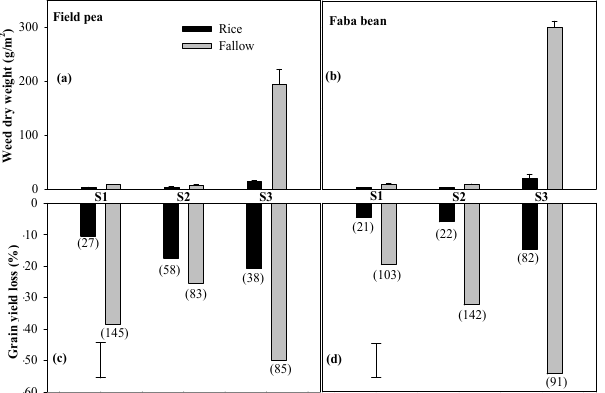
Figure 7. Weed dry weight ( a ), ( b ) and grain yield loss ( c ), ( d ) in post ‐ rice and post ‐ fallow pea ( a ), ( c ) and faba bean ( b ), ( d ) at three sowing dates (S1, S2 and S3). Error bars projecting from shaded vertical bars represent the standard deviation of the mean ( n = 4). Error bars in the lower left corners of Panels ( c ) and ( d ) indicate LSD values at the 5% level of significance. The values in parentheses represent grain yield losses in non ‐ weeded plots (LSD 0.05 = 25 for field pea and 92 for faba bean). Chocolate spot ( Botrytis fabae ) and Ascochyta blight ( Ascochyta fabae ) were detected in crops sown